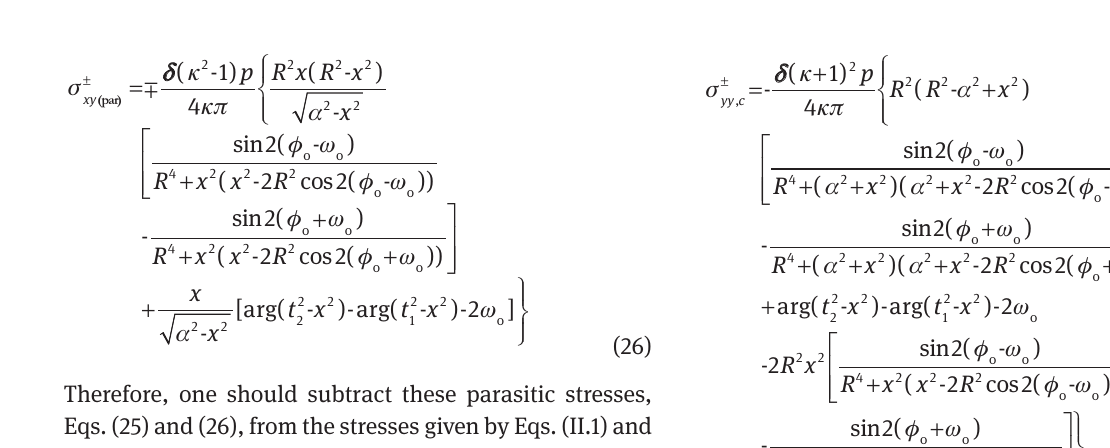
Figure 6 The development of parasitic stresses (out of